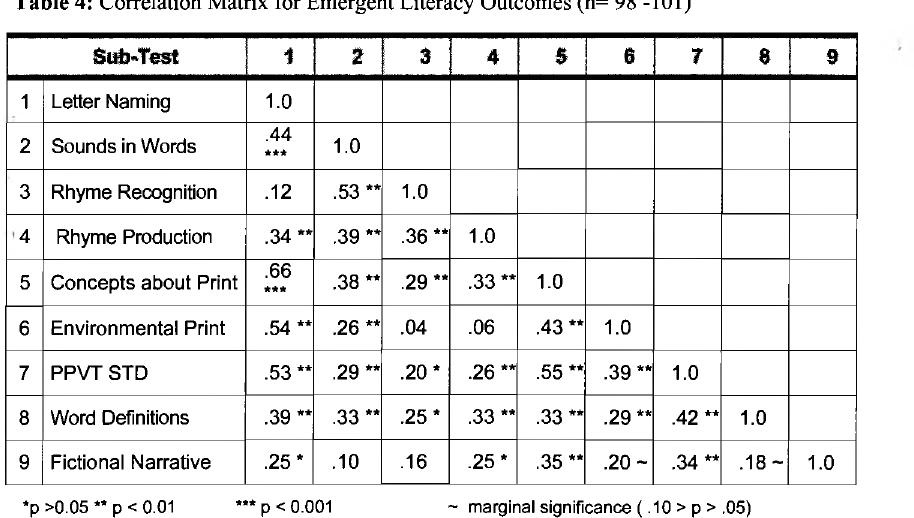
Table 4: Correlation Matrix for Emergent Literacy Outcomes (n= 98